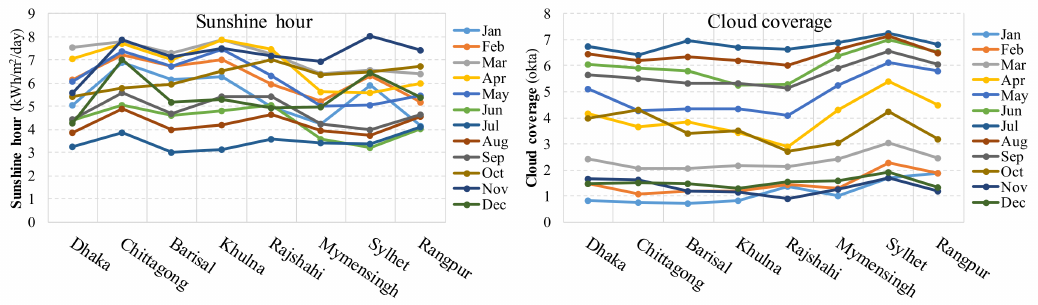
Figure 6. Average bright sunshine hour and cloud coverage in eight divisions of